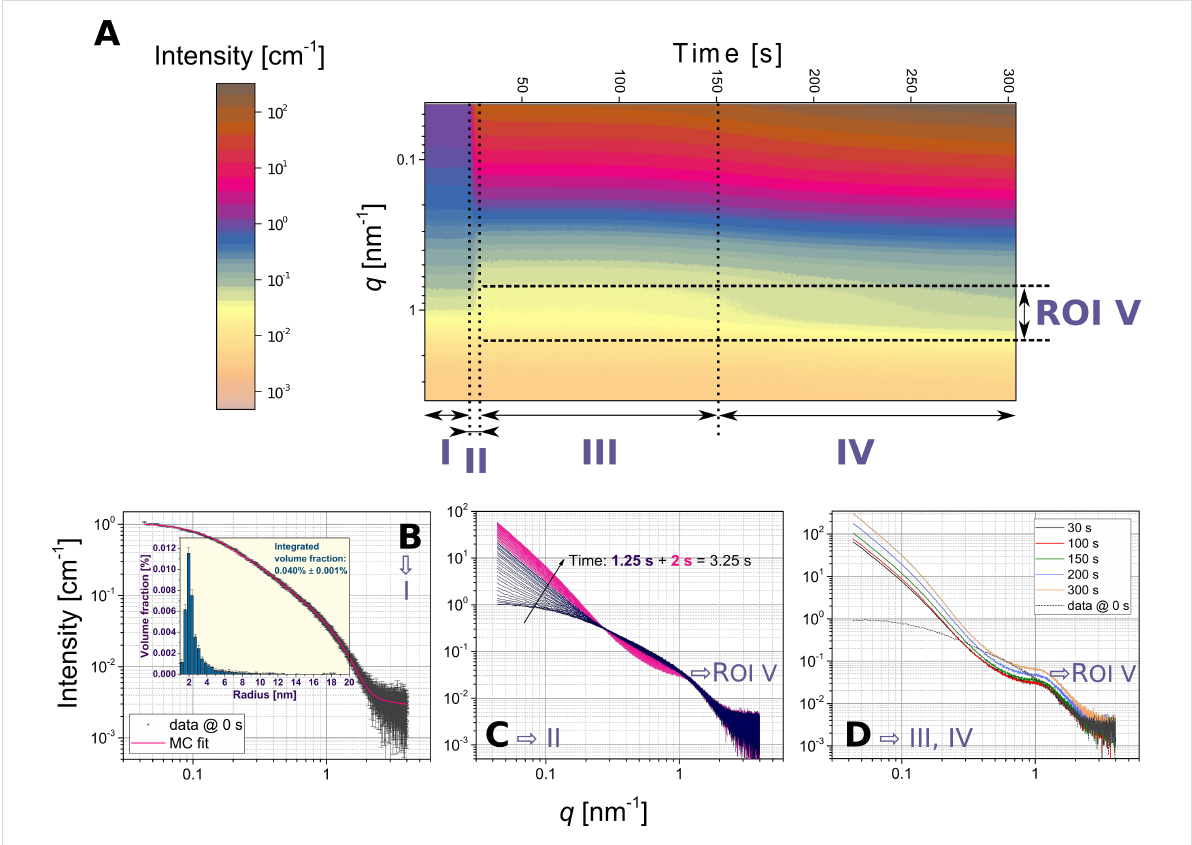
Figure 1: Time-resolved and in situ SAXS patterns documenting the formation of silica–lysozyme aggregates from an experiment where data was re- corded at a rate of 50 ms/pattern (20 fps); A) contour plot depicting the scattering intensity as a function of q and time. The changes in the data reveal four distinct time periods; I – scattering from pure silica NPs, II – the moment of lysozyme injection, III – the growth of the aggregates/composites with the original form factor of the silica NPs preserved, and IV – further growth of aggregates and a change in the original silica NPs. We further identified a q -range as a region of interest “ROI V” indicating a local maximum due to interparticle correlations; B) the initial silica NP form factor with a Monte Carlo (MC) fit and the derived discrete particle size distribution (inset); C) the scattering data for period II showing the time frames spanning the injec- tion of the LZM solution between 24.25 s and 27.50 s of the experiment, with the first 1.25 s (blue) dominated by the formation of large aggregates, followed by ca. 2 s (pink) during which the local maximum related to the interparticle interactions (ROI V) clearly developed; D) selected patterns spanning periods III and IV highlighting the differences in the form factor of the silica particles ( q > 1.5 nm − 1 ). In C) and D) the data uncertainties are not shown for clarity.